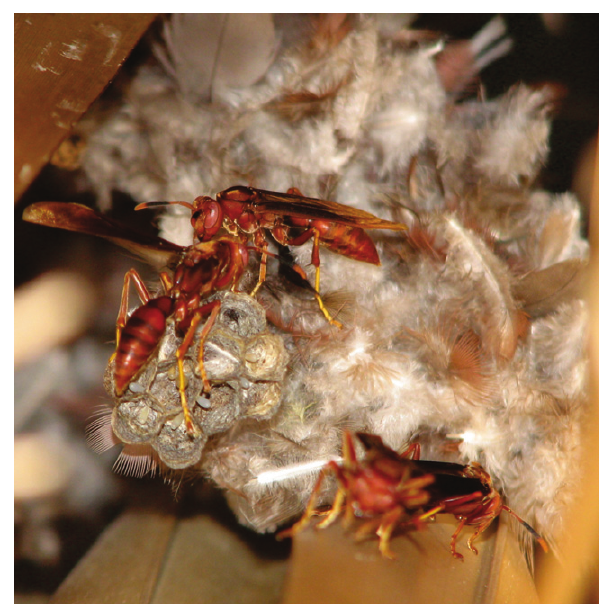
Figure 1. Wasps building their nest on Neotropical palm swift nests. Photo by Vitor O. Lunardi.